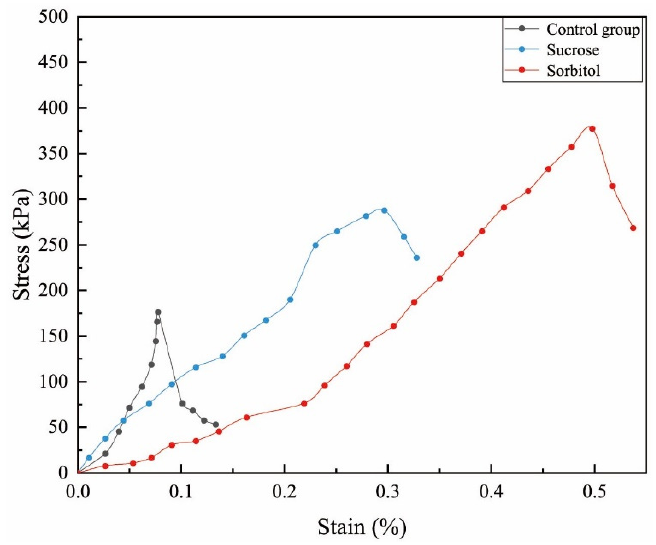
Figure 7. Stress–strain response of EICP solidified sand with different nucleating agents.